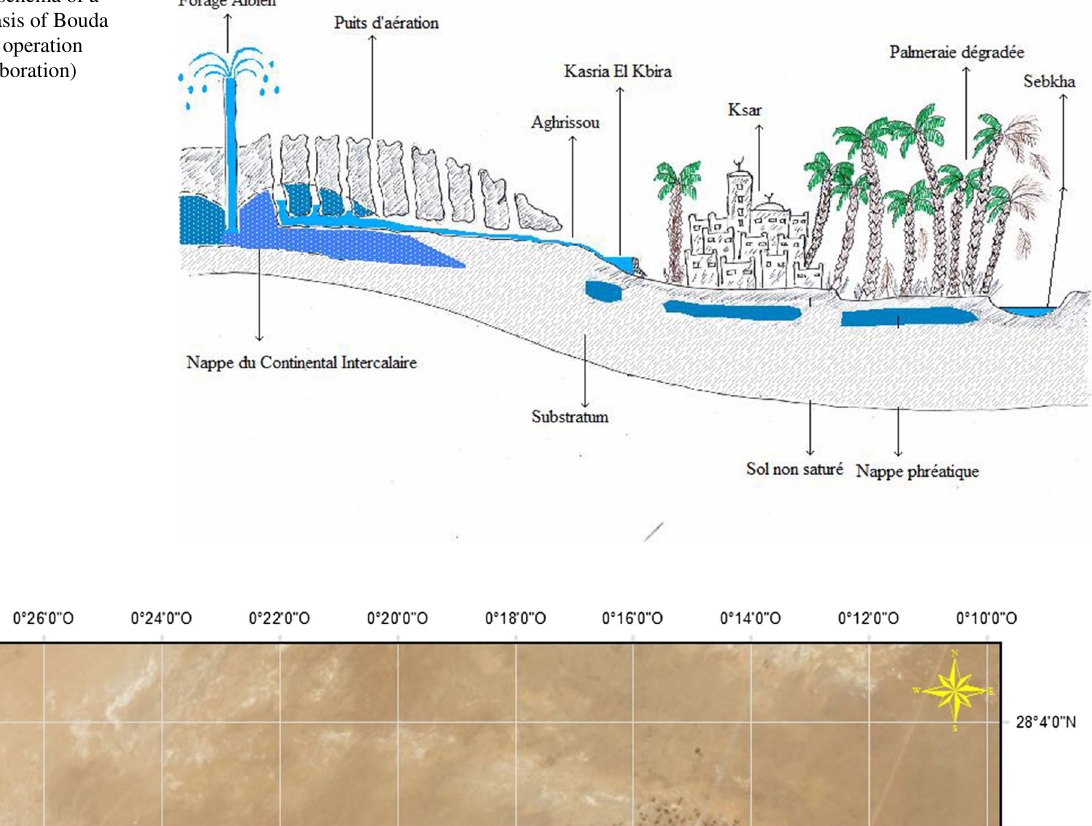
Fig. 8 Probable schema of a foggara of the oasis of Bouda after the drilling operation (1998). (own elaboration)